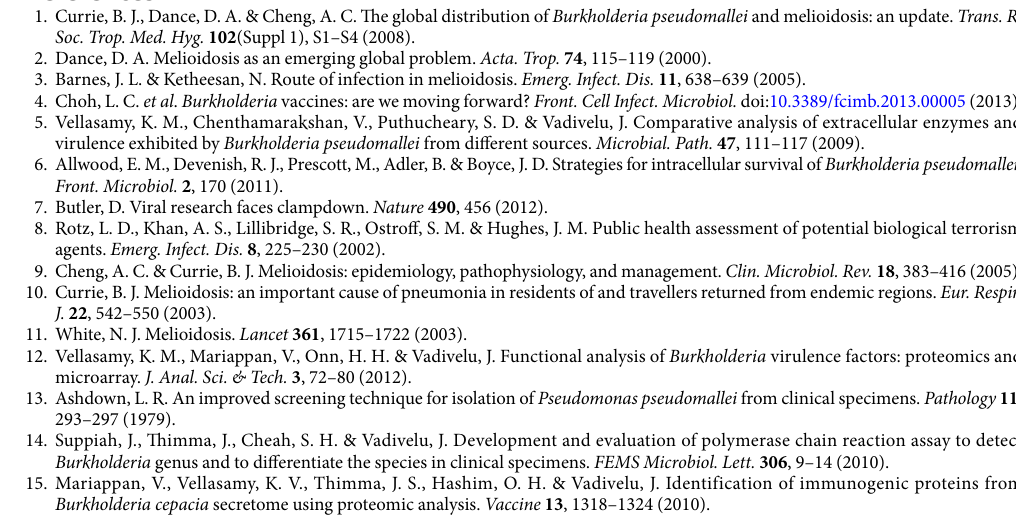
Apart from that, we also observed several proteins involved in virulence and/or persistence which were either absent or present in both Bp MARAN and Bp mouse-adapted , particularly catalase/peroxidase (KatA). Lefebre et al . 39 con- clude that the catalase/peroxidase is has a novel function by contributing to maintain the normal activity of the tricarboxylic acid (TCA) cycle, and plays a global role in cellular protection against oxidative stress 40 . Modulation of outer membrane protein and several periplasmic transpoters were also observed, which may regulate homeo- stasis and structure of the B. pseudomallei envelope. The observations underline the significance of crucial patho- genesis of B. pseudomallei in terms of the interplay between bacterial counter-host immune mechanisms. In summary, our results imply that both the host and the B. pseudomallei factors are involved in the development of the pathogenic outcome of infection. The identified proteins suggest differences in the pathogenic potentials of B. pseudomallei to infect and cause disease in man. Thus, this in vivo study provided a comprehensive description of the proteomic differences between the soil and mice-passaged B. pseudomallei , which is particularly imperative, since they revealed information that could not have been predicted using classic in vitro growth conditions. Based on our analysis, the proteins that were differentially expressed between the B. pseudomallei soil strain and its mouse adaptive variant contributed to host colonisation and adaptation by modulating stress response, metabolism, virulence, and colonisation-associated proteins. The data on the role of these proteins in colonisation may highlight the importance of these proteins in the establishment of infection, provide information for the development of novel vaccine candidates, and indicate intervention modalities for the prevention or treatment of B. pseudomallei infections.